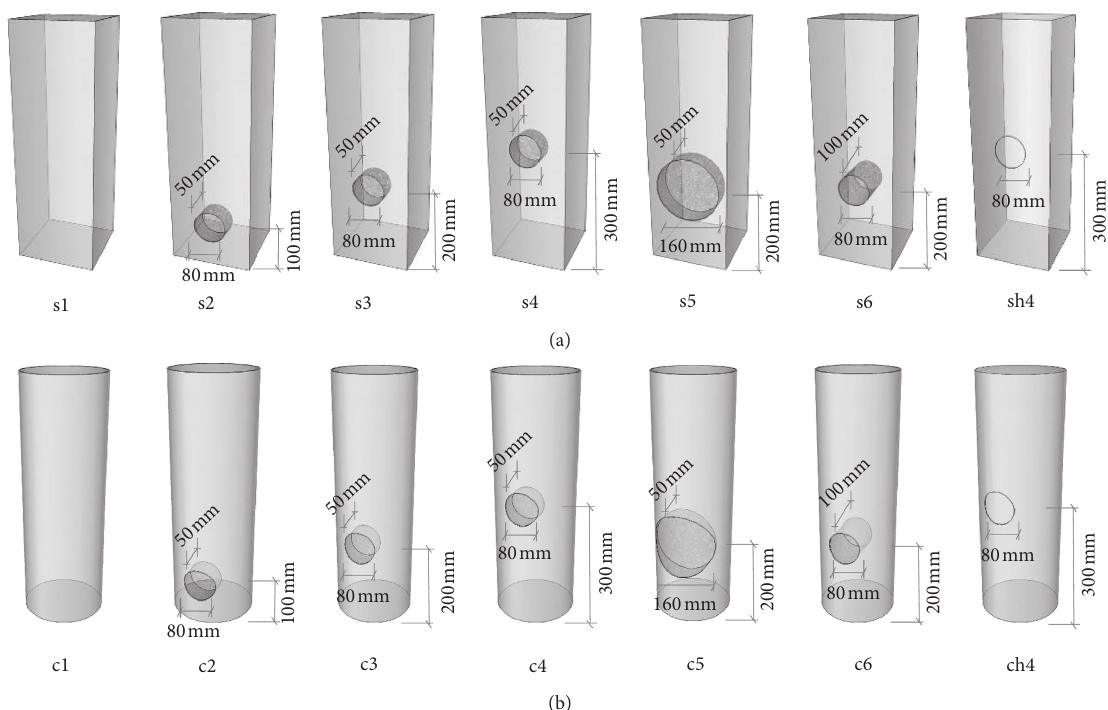
Figure 1: Schematic views of the CFST columns with hole. (a) Square section. (b) Circular